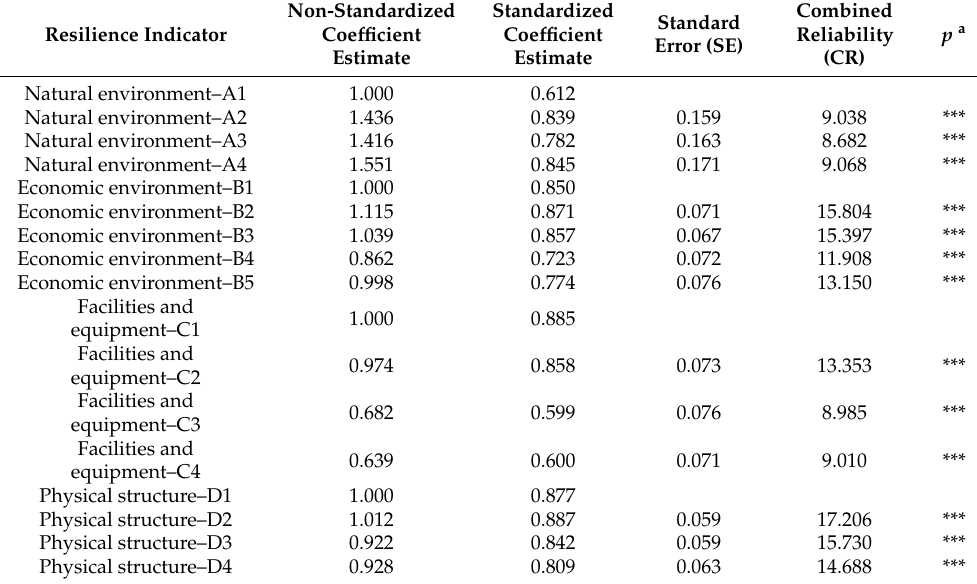
Table 10. Parameter estimates and fitness test of the first-order structural equations